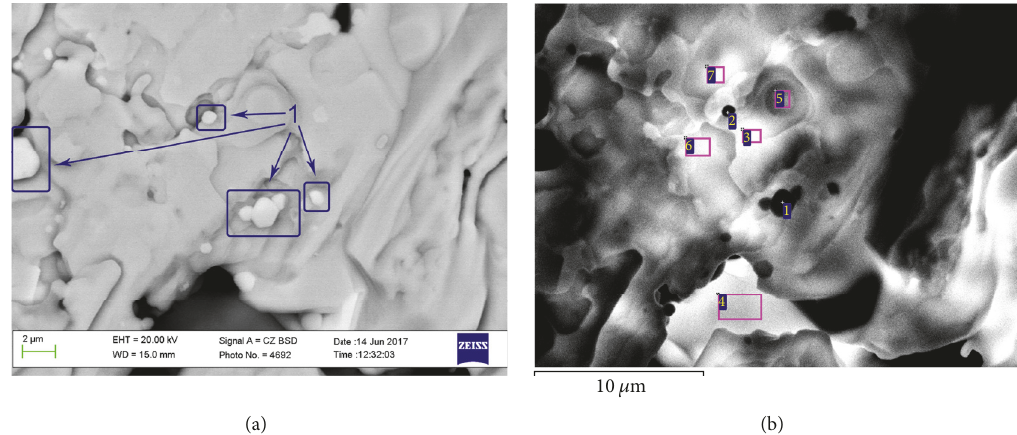
Figure 3: SEM images of PbCdI 2 thick films obtained in phase-contrast mode (a) and VPSE mode (b). Very bright hexagons, marked in (a), correspond to microcrystallites of PbI 2 embedded in the CdI 2 matrix. The brightness of the areas presented in (b) corresponds to the intensity of their cathodoluminescence.